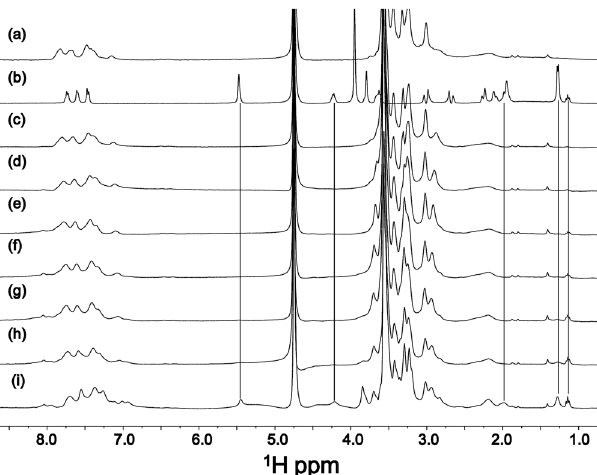
Figure 9. 1D 1 H NMR spectra acquired at 298 K of ( a ) La-(2-Nal) 2 at 2.5 mg/mL, ( b ) DOX 0.5 mg/mL, ( c ) La- (2-Nal) 2 at 2.5 mg/mL + DOX 0.05 mg/mL, ( d ) La-(2-Nal) 2 at 2.5 mg/mL + DOX 0.1 mg/mL, ( e ) La-(2-Nal) 2 at 2.5 mg/mL + DOX 0.2 mg/mL, ( f ) La-(2-Nal) 2 at 2.5 mg/mL + DOX 0.3 mg/mL, ( g ) La-(2-Nal) 2 at 2.5 mg/ mL + DOX 0.4 mg/mL, ( h ) La-(2-Nal) 2 at 2.5 mg/mL + DOX 0.5 mg/mL, ( i ) La-(2-Nal) 2 at 2.5 mg/mL + DOX 1 mg/mL. In the lowest spectrum a few peaks arising from doxorubicin appear, as indicated by the black